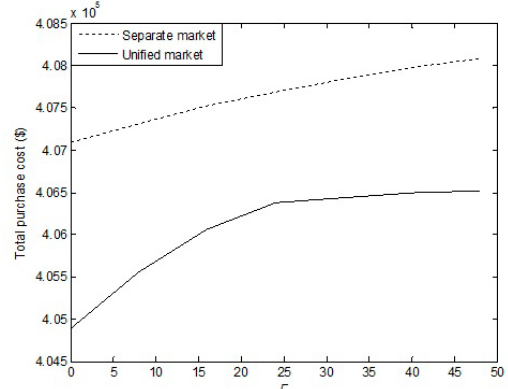
Figure 11. The impact of Γ on the total cost.